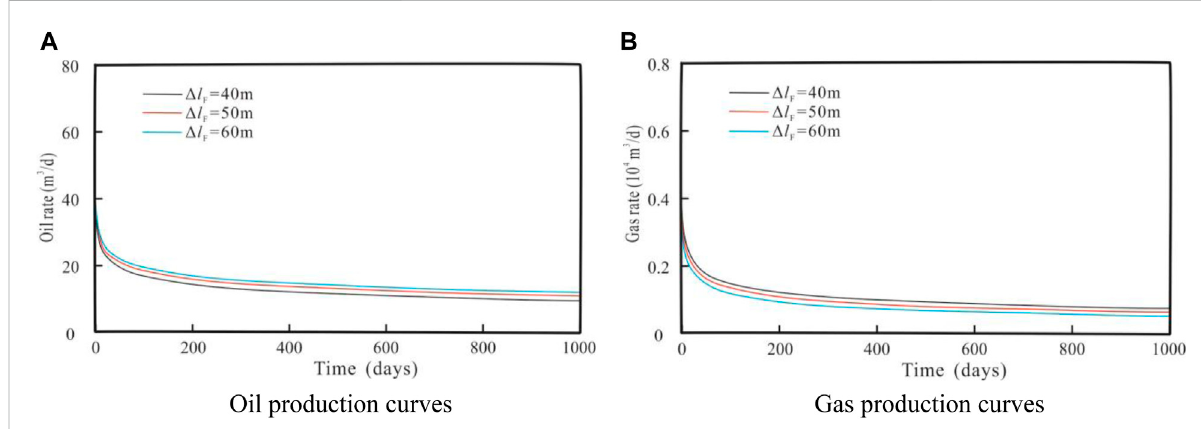
FIGURE 7 Effect of fracture half-length on production dynamic curves.